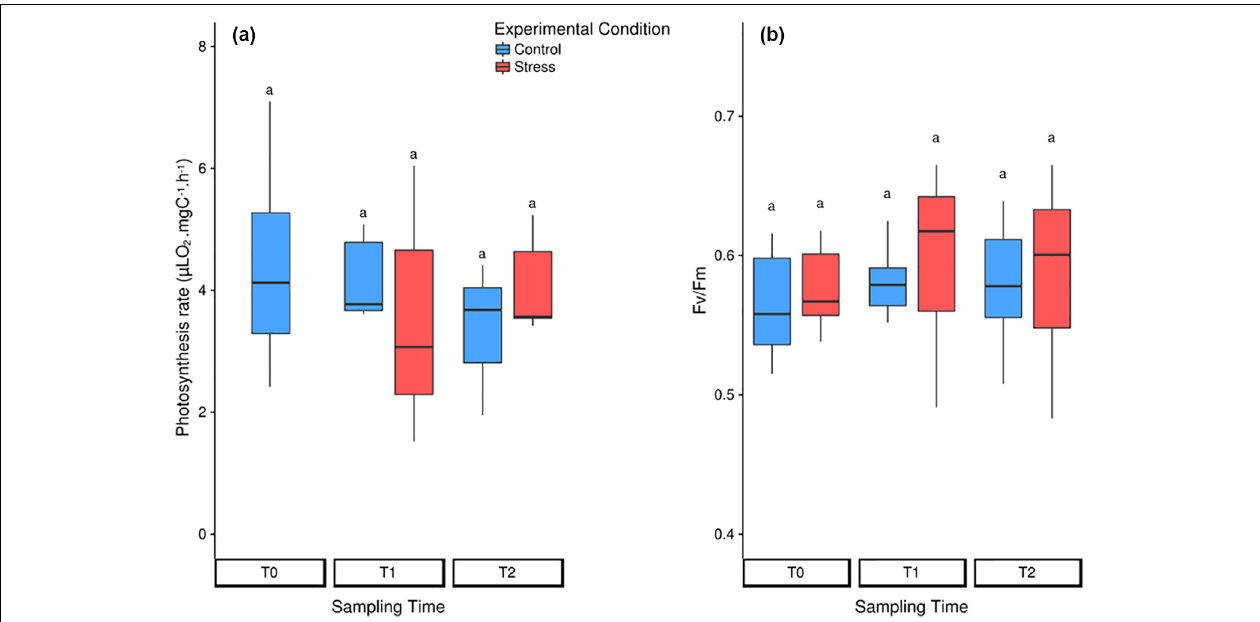
FIGURE 5 | Photosynthetic rates of the symbionts in control (blue) and heat-stressed (red) colonies of Collozoum pelagicum . (a) Box-plots of photosynthesis rates measured by oxygen production, when normalized by the symbiont surface of the colony. (b) Box-plots of PAM-microscopy measurements. Pairwise comparison from permutation test between each condition was represented by letters. Statistical supports are described in Supplementary Tables 1, 4D,E .